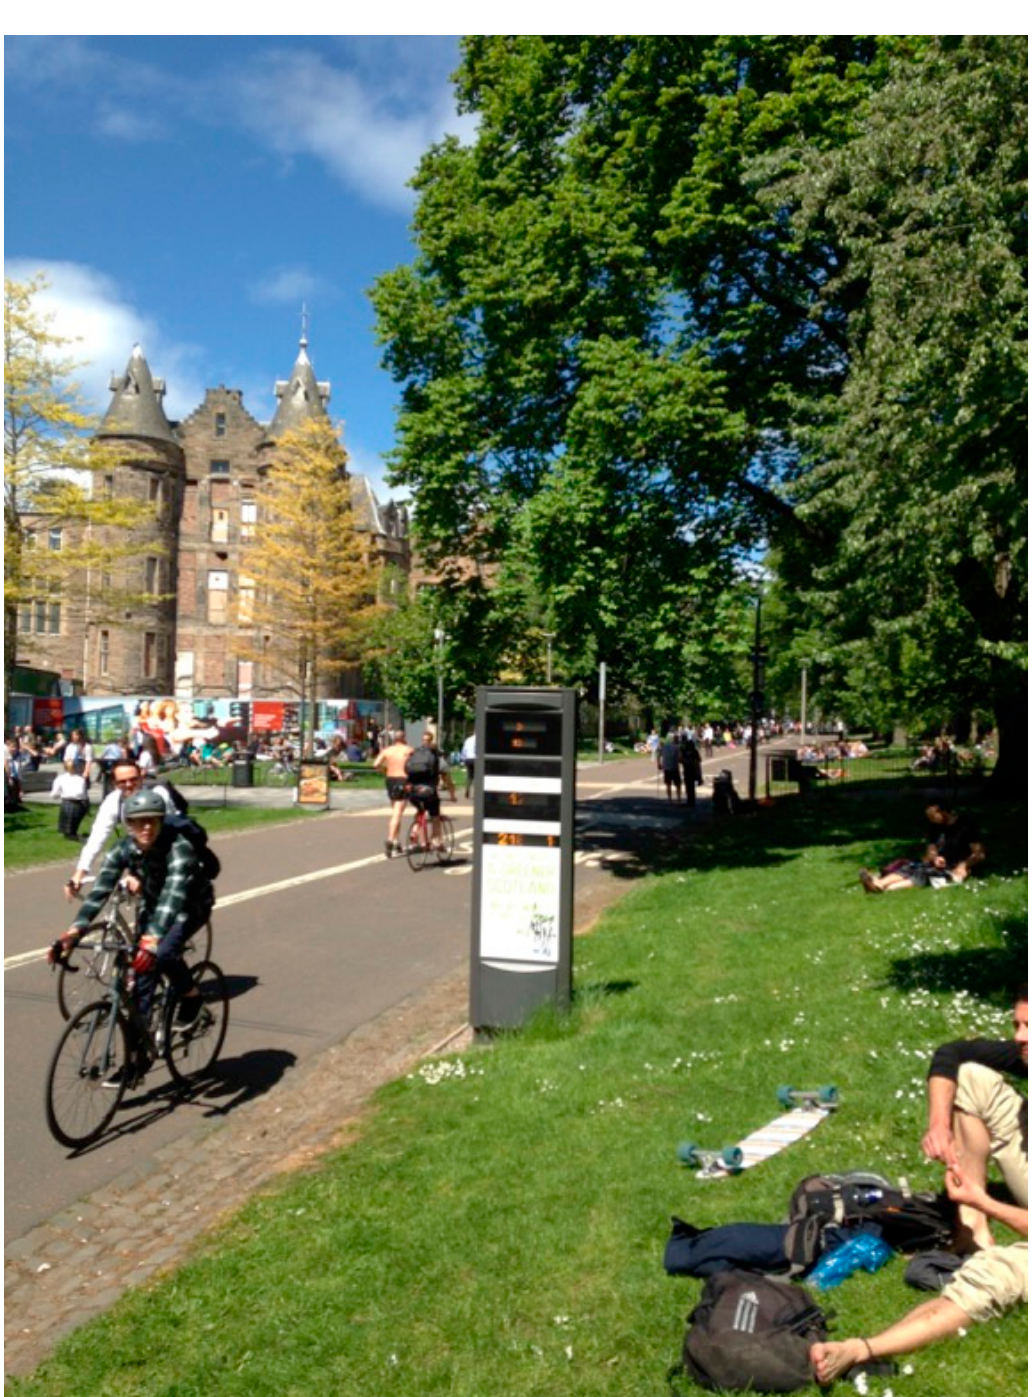
Figure 5. Cyclists and pedestrians utilizing the Middle Meadows Walk. Note the designated cycle lane and bicycle counter (Photo by G.L. Buckley, June